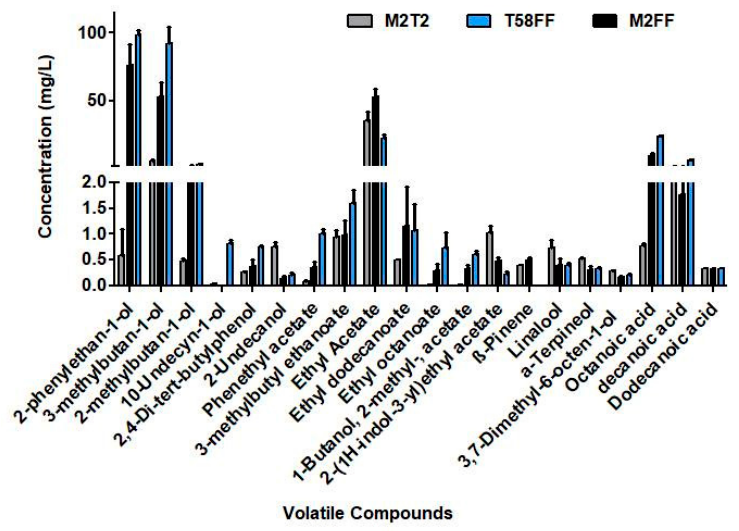
Figure 3. Concentration of volatiles organic compounds during fermentation in M2 and T58: M2 at 9 days corresponds to the H. uvarum L2 fermentation (M2T2) and 14 days corresponds to the adjunct of S. cerevisiae US-05 (M2FF) and T-58 (T58FF). Data are reported as means ± SD. Where not visible, error bars lie below the symbols. Histogram bar with two segments option was generated by using GraphPad Prism software (GraphPad Prism 5.03 GraphPad Software Inc., La Jolla, CA, USA). M2 showed higher levels of ethyl acetate (35.52 mg/L) than T58 (23.06 mg/L), both over the odor threshold of 21.00 mg/L. The 3-methylbutyl ethanoate remained below the odor threshold (1.20 mg/L) in M2 until the end of fermentation (0.98 mg/L), while in T58, it slightly exceeded it (1.6 mg/L). The concentrations of phenylethyl acetate remained below the odor threshold in all